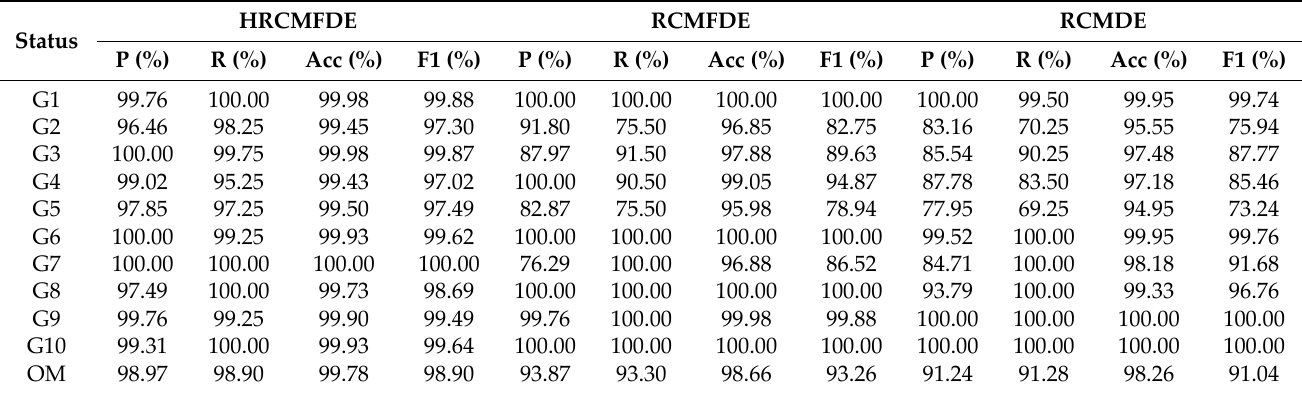
Table 11. Comparison of different models.